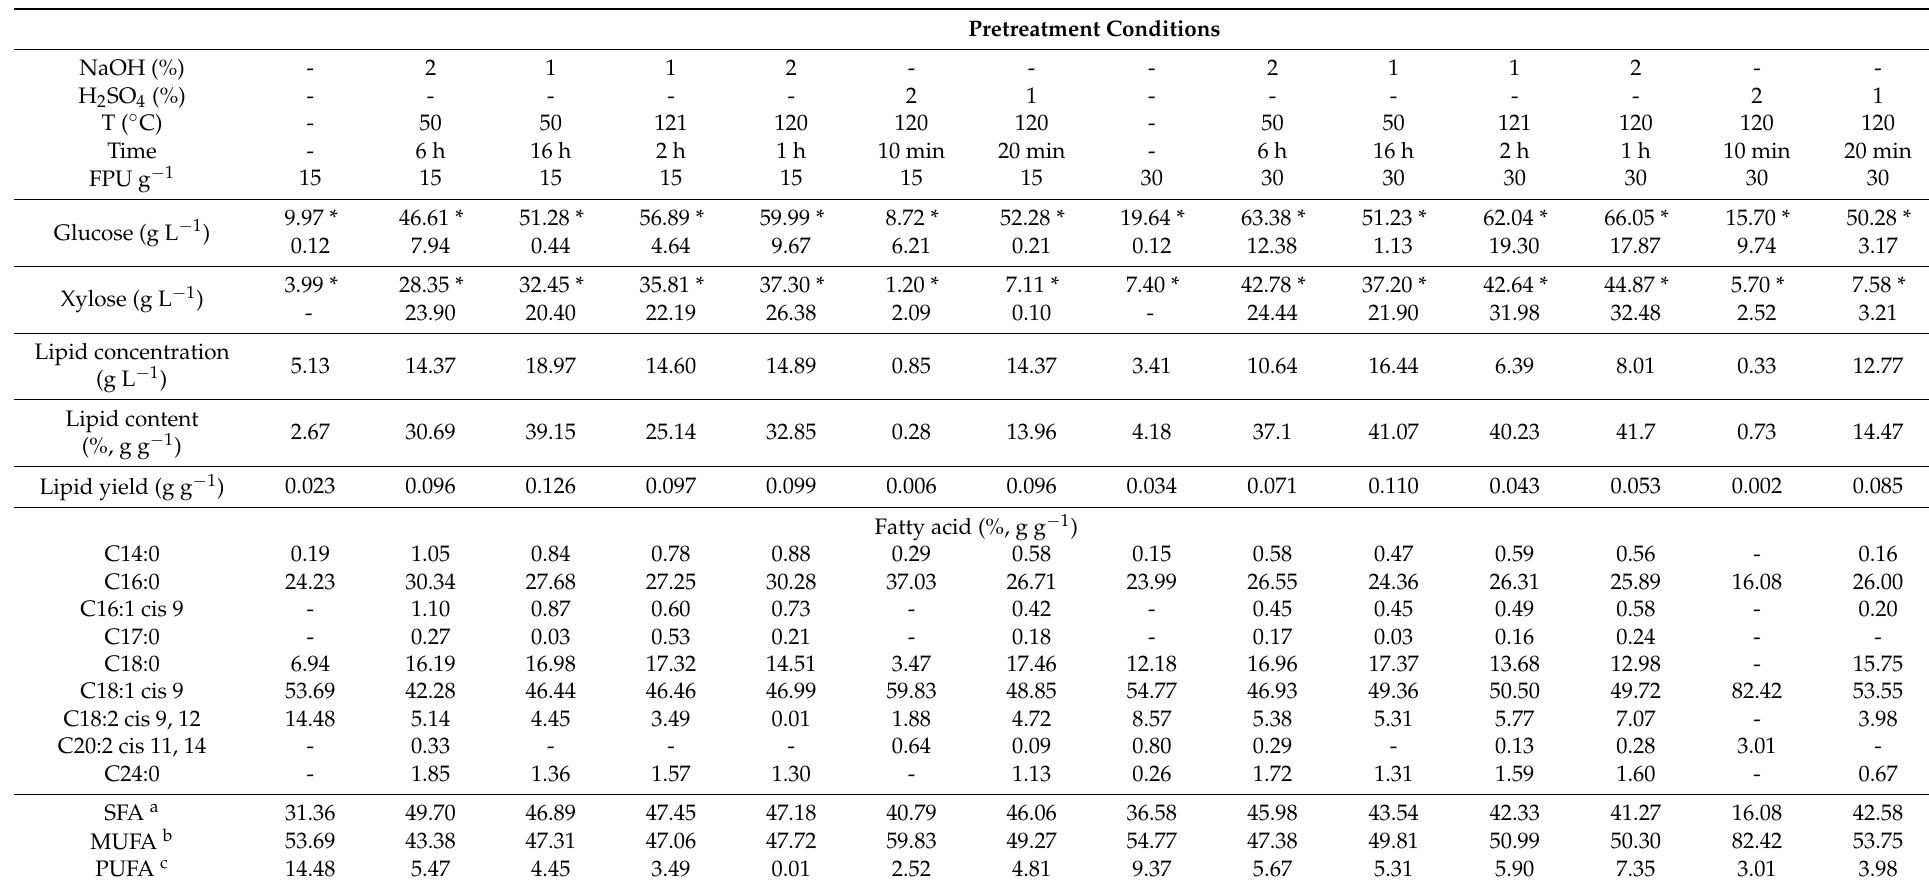
Table 3. Cultivation of T. oleaginosus on enzymatic hydrolysate of raw and pretreated corn cobs. Lignocellulosic biomass was hydrolyzed using 15 and 30 FPU of Cellic CTec2 per gram of glucan. The concentration of glucose, xylose and lipids, lipid content in solid residue and fatty acid composition of extracted lipids were determined at the end of